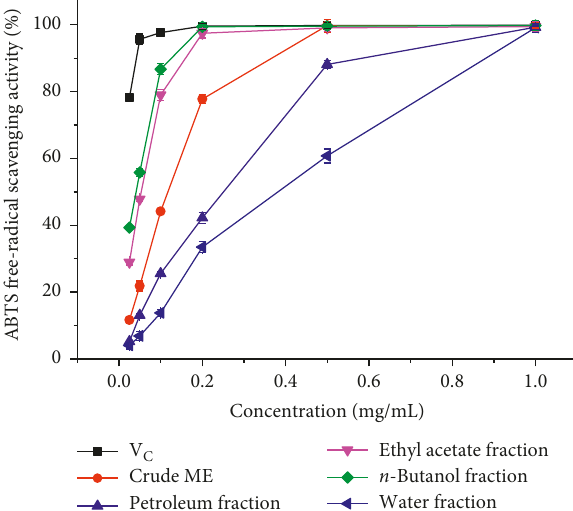
C , BB, BC, and BD Figure 5: ABTS-scavenging activity of crude ME, V extraction fractions extracted from ME.